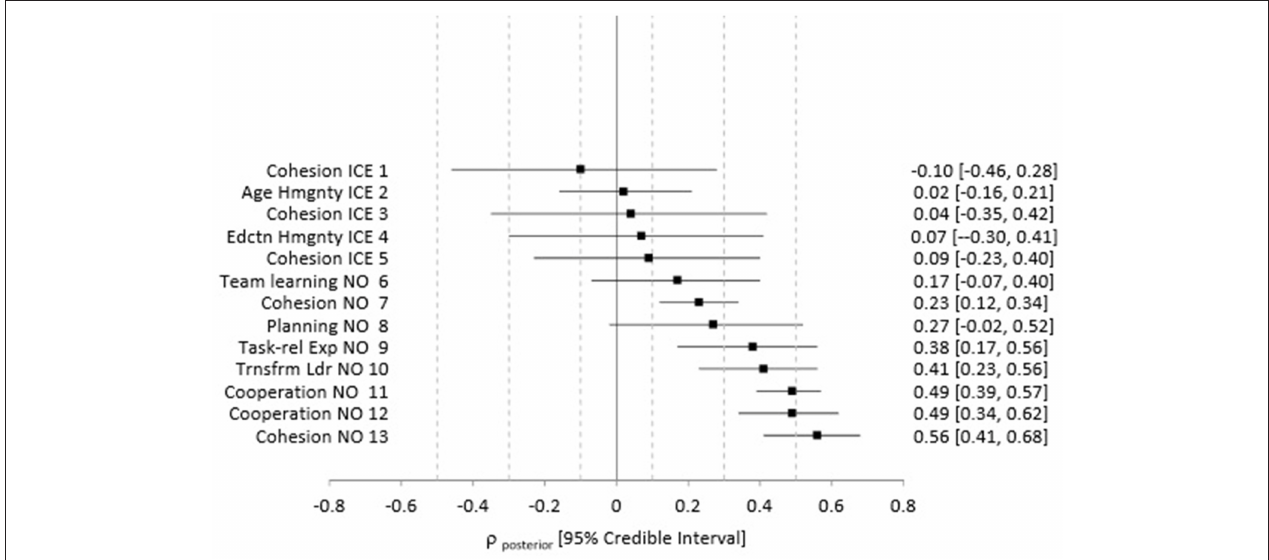
FIGURE 2 | Estimated distributions for the predictor and team performance relationship in analog environments. ICE = analog team was in an ICE environment (e.g., Winter-overs in Antartica) NO = team was living and working together but not in an ICE. Hmgnt = Homogenity. Task-rel Exp = task-relevant experience. Trnsfrm Ldr = Transformational Leadership. The square represents the weighted average local validity population estimate ( ρ posterior ) and the bar represents the 95% credible interval. Specific estimates are provided in the right column as per ρ posterior [95% credible interval]. The credible interval can be interpreted as follows: there is a 95% chance that the true population predictor and team performance relationship ( ρ ) is between the first number and the second number. Number in the left column indicates the analog data source. 1. Gunderson and Nelson (1963), Outcome = self-report team achievement, Antarctic stations; 2 and 4 from Gunderson and Ryman (1967), Outcome = team accomplishment, mixed sources, Antarctic stations; 3. Emurian and Brady (1984), outcome = performance on lab task; 10-day isolated lad experiment; 5. Nelson (1964), outcome = supervisor ratings of individual performance aggregated within station, Antarctic station; 6, 8, and 9 Knight (2015) , outcome = team’s time and number of obstacles completed in a final challenge task, military training; 7 and 11 Kniffin et al. (2015), outcome = supervisor rating of performance, firehouses; 10, 12, 13. Ko (2005), outcomes = team performance, mixed sources, special operations teams.